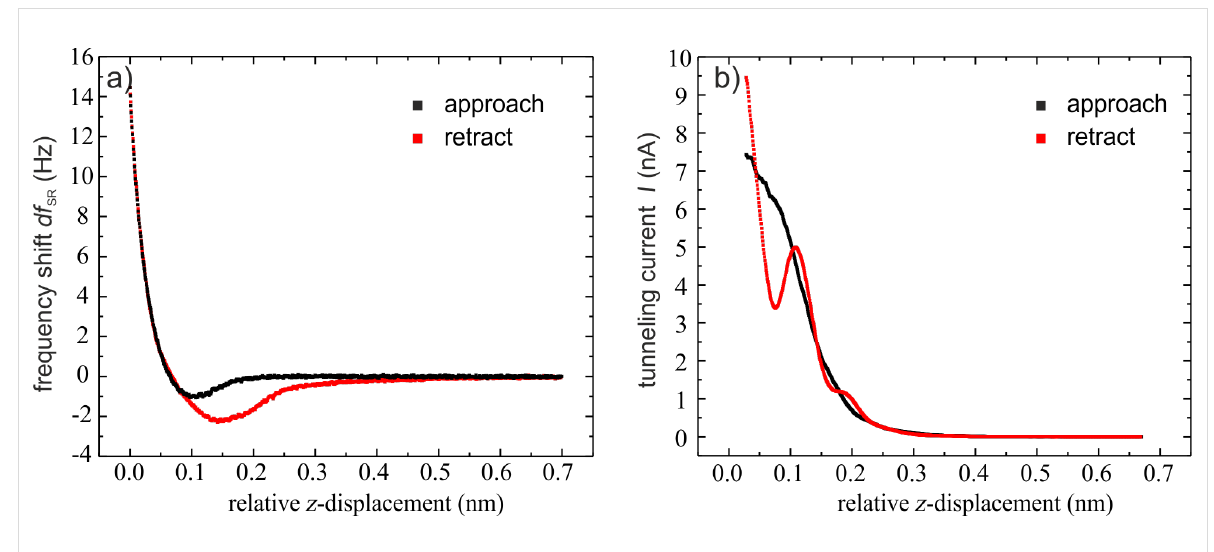
Figure 3: (a) Frequency-shift versus distance curve. The contribution from the long-range forces has been subtracted. The spectroscopy measure- ment was recorded with an oscillation amplitude of 2.8 Å and a bias voltage of 0.1 V to eliminate the electrostatic interaction. The black curves repre- sent the approach of the tip to the surface, the red curves the retraction. (b) Simultaneously recorded tunneling current.